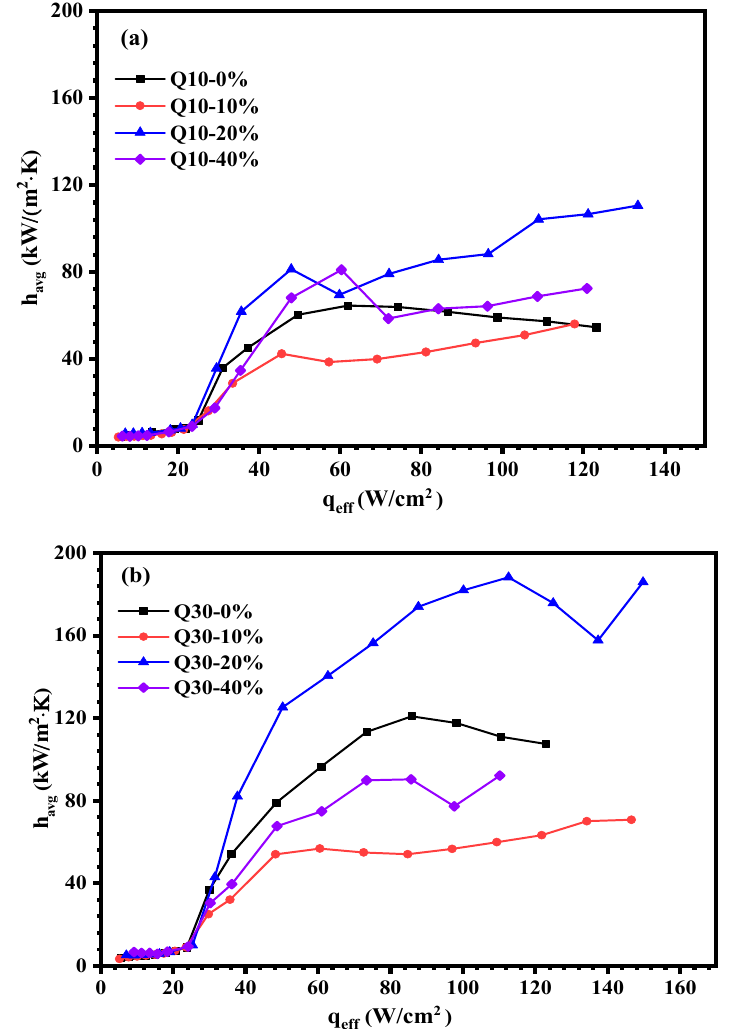
Figure 8. HTC curves of porous-microchannel samples with different PFA contents. ( a ) Q10-series; ( b ) Q30-series. For Q30 series, the variation in HTC against heat flux is shown in Figure 7b. Compared with the Q10 series, Q30 series shows better heat transfer performance than Q10 series